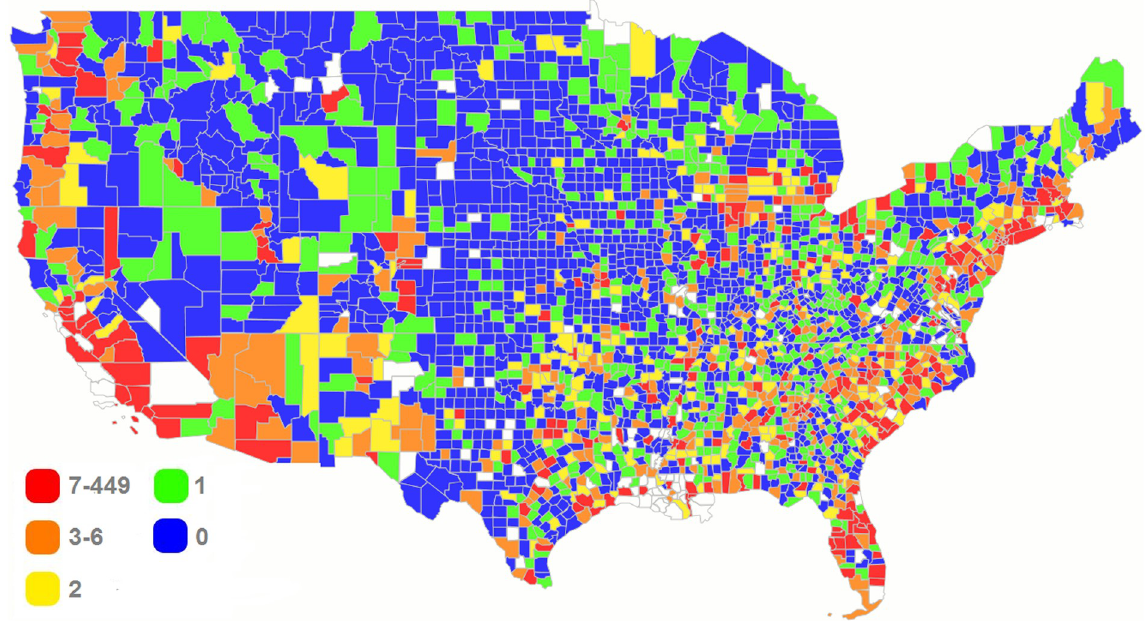
Fig 2. Heat map of total number of gun homicide incidents by county in the contiguous US, 2015. White indicates counties for which no data were available. Created with Mapline mapping software (https://mapline.com), which uses OpenStreetMap geodata (https://openstreetmap.